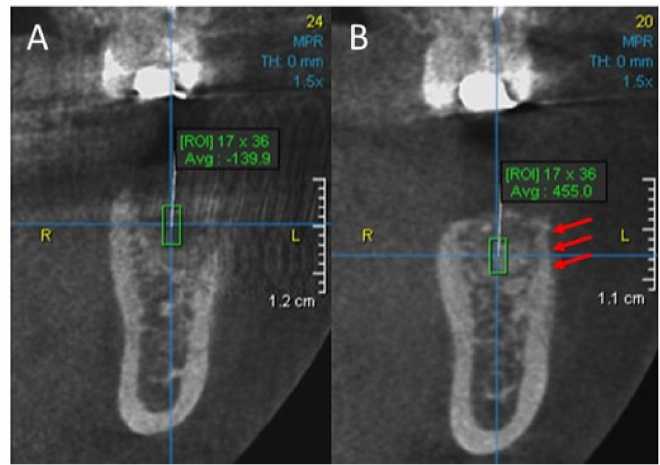
Figure 4. Grey levels in rectangular ROI at the site of augmentation. ( A ) CBCT scan ten days postoperatively. ( B ) Cone beam computed tomography (CBCT) scan 6 months post augmentation with ISBG. Pay attention to buccal bone plate regeneration at the site of augmentation (red